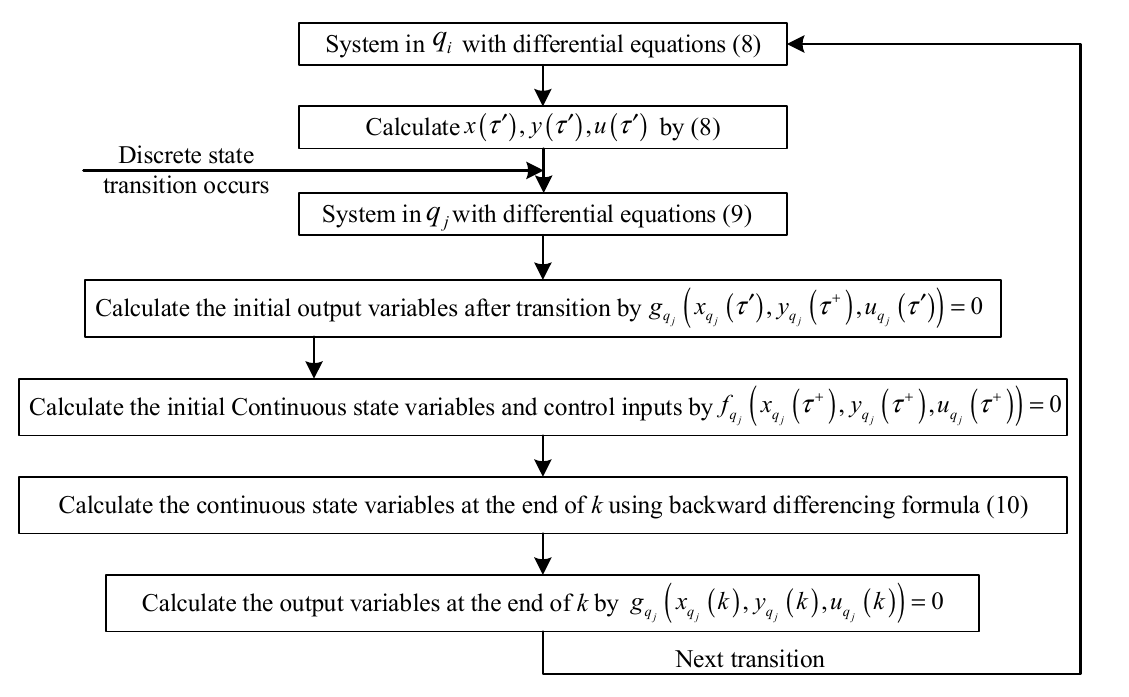
Figure 2. Initial condition calculation flow chart when the discrete state transition occurs.